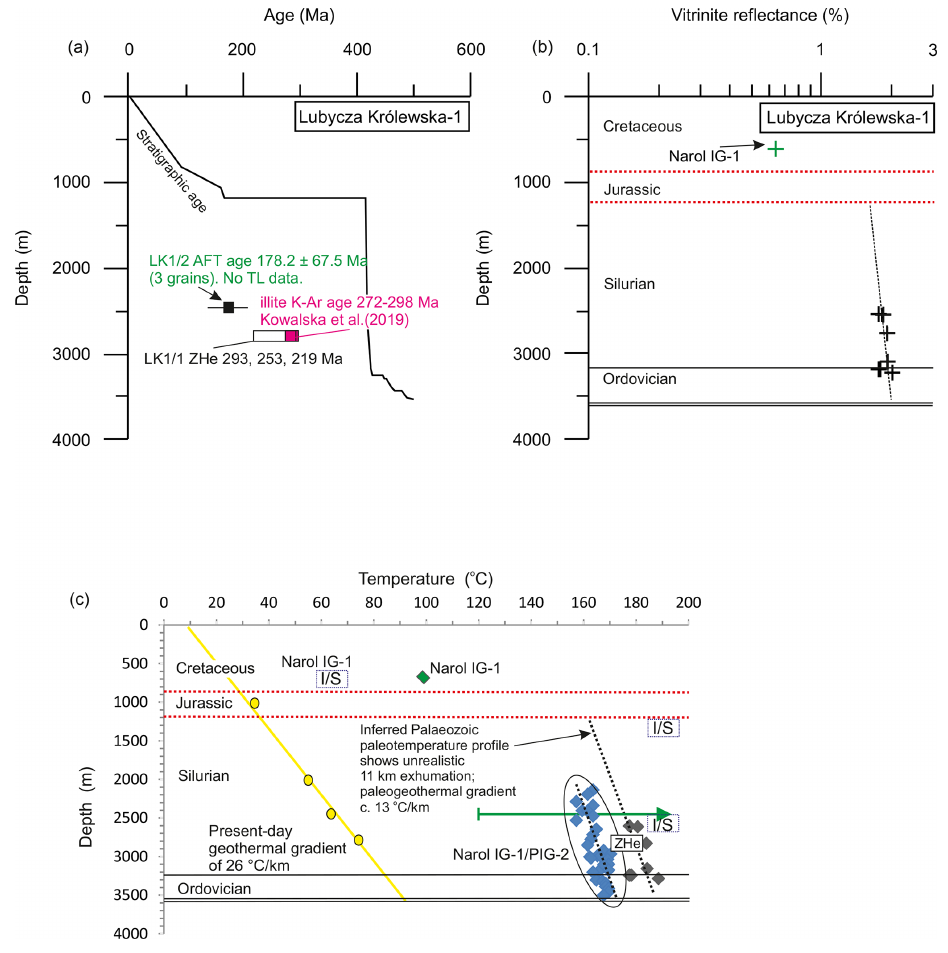
Figure 12. Lubycza Królewska-1 borehole data (Lublin Basin). (a) Thermochronological data vs. stratigraphic age, (b) VR profile, (c) pale- otemperature profile. Other explanations are as in Figs. 6 and 7. VR and illite/smectite (I/S) data from the Narol IG-1/PIG2 boreholes are not to scale. A thermal maturity break exists between the Mesozoic and Paleozoic. VR data from the Narol IG-1/PIG2 boreholes show a similar paleogeothermal gradient to that in the Lubycza Królewska-1. The inferred Paleozoic paleotemperature profile of the Lubycza Królewska-1 borehole shows an unrealistic 11km of exhumation with a paleogeothermal gradient of 13 ◦ Ckm − 1